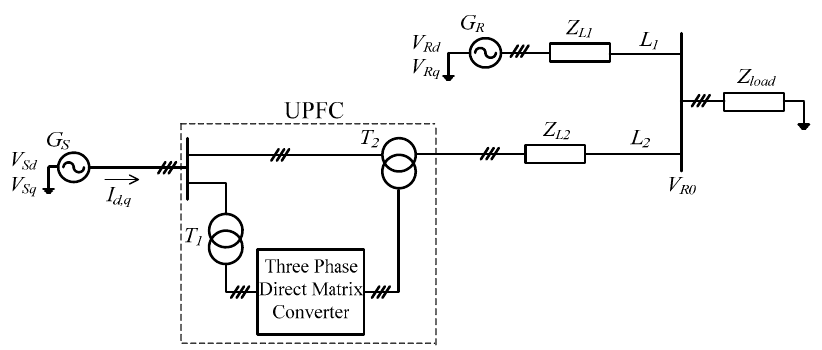
Figure 1. Transmission network with DMC-UPFC.